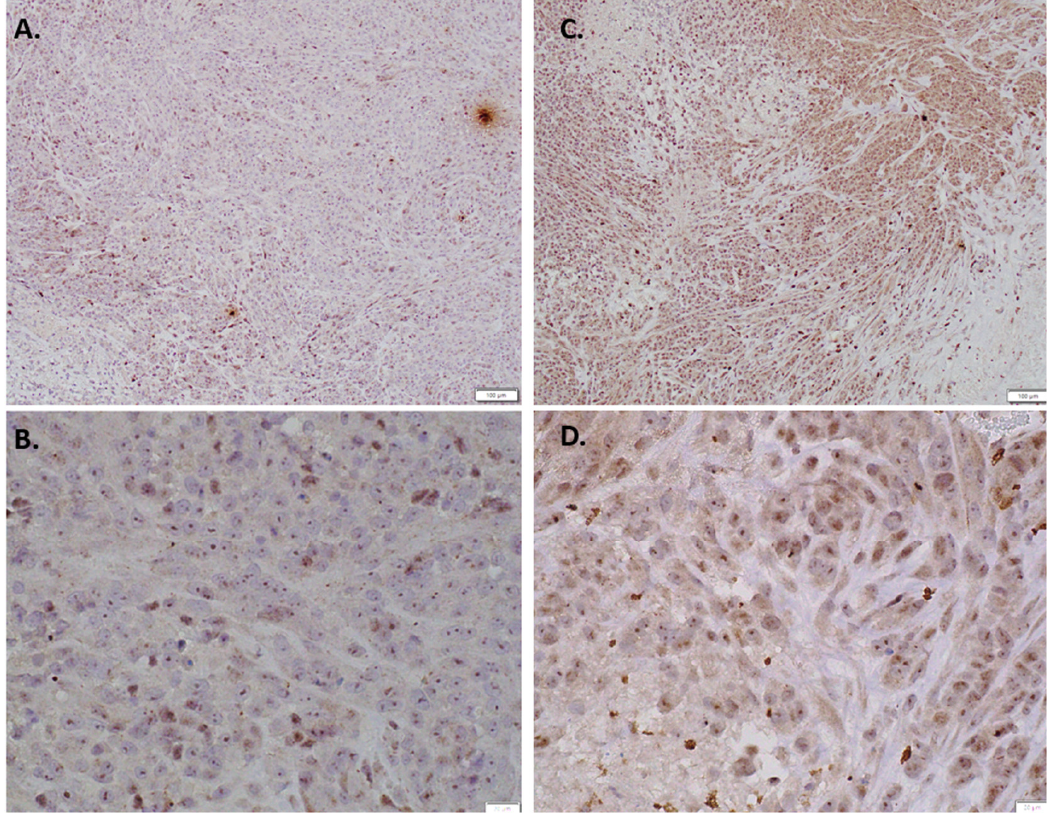
Figure 4. Immunohistochemical staining EPH receptor A3 staining with ( A ) Control (10×) ( B ) Con- trol (40×) ( C ) Indolium 1 Treatment (10×) ( D ) Indolium 1 Treatment (40×). Note increased EPHA3 staining in treated tumors ( C , D ).